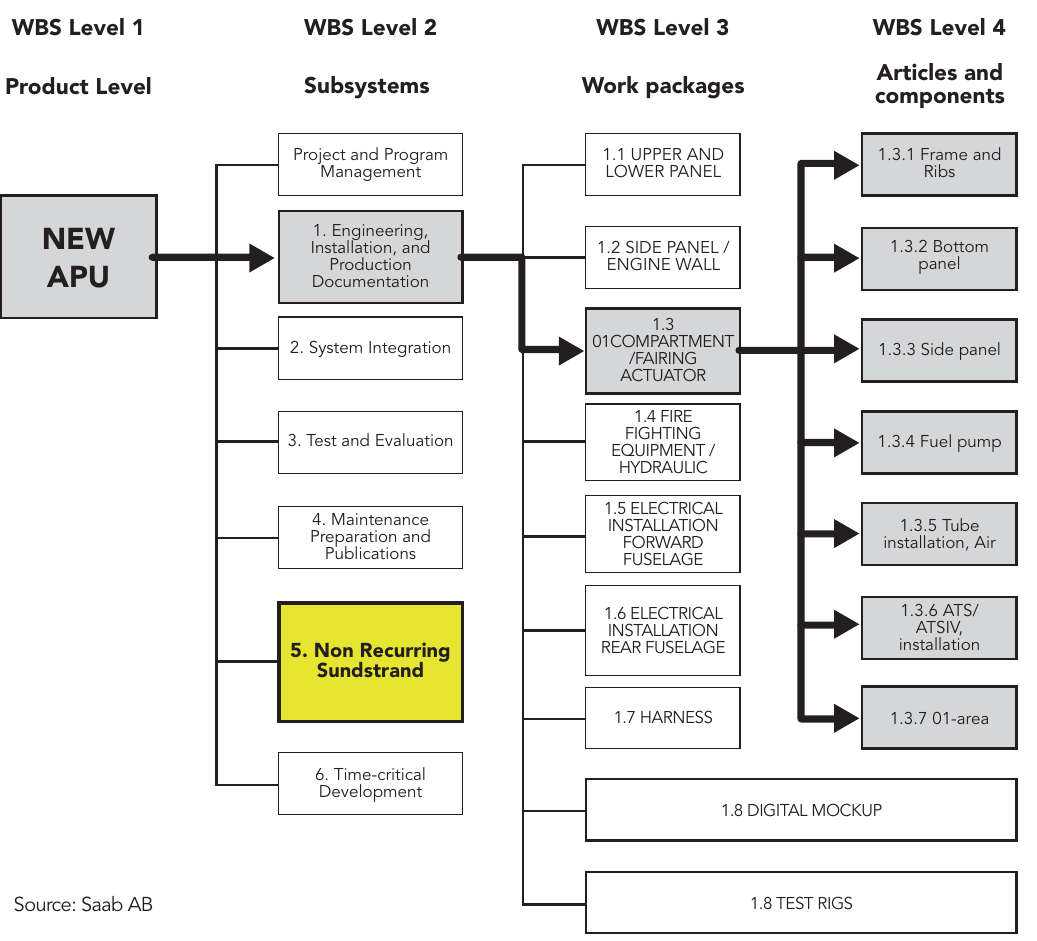
Figure 4: APESS - Work breakdown structure on four